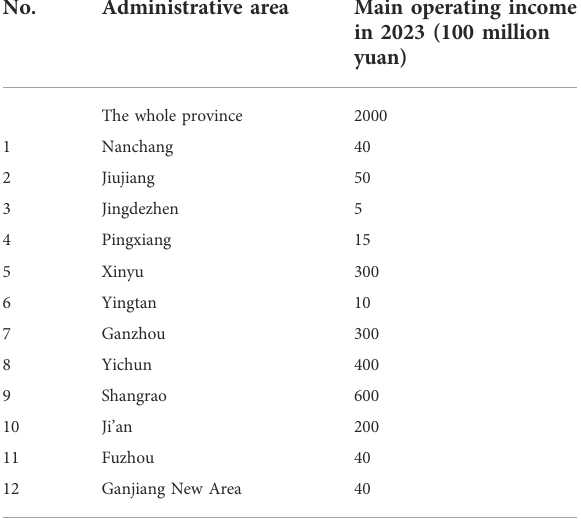
TABLE 3 Breakdown of high-quality leap-forward development of new energy industry in Jiangxi Province, China.